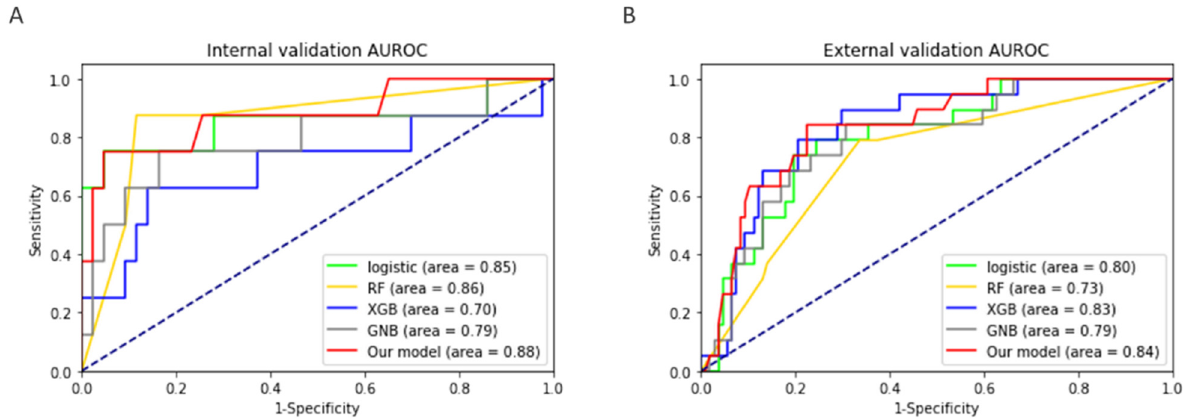
Figure 3. Comparison of performance of well-known machine learning models. The ( A ) internal and ( B ) external validation areas under the receiver operating characteristic (AUROC) plots. GNB, Gaussian naïve Bayes; RF, random forest; XGB, XGBoost.